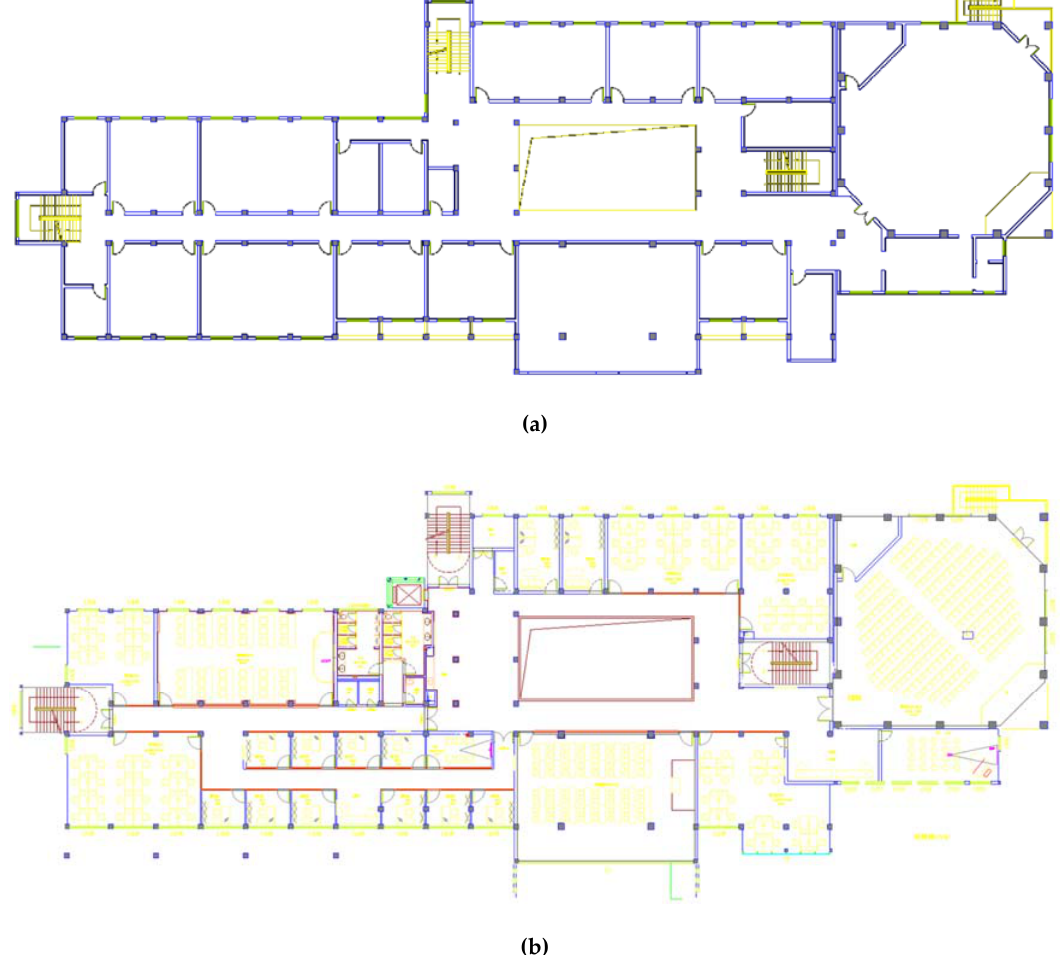
Figure 4. Second-floor plan. ( a ) Second-floor plan before refurbishment. ( b ) Second-floor plan after refurbishment.